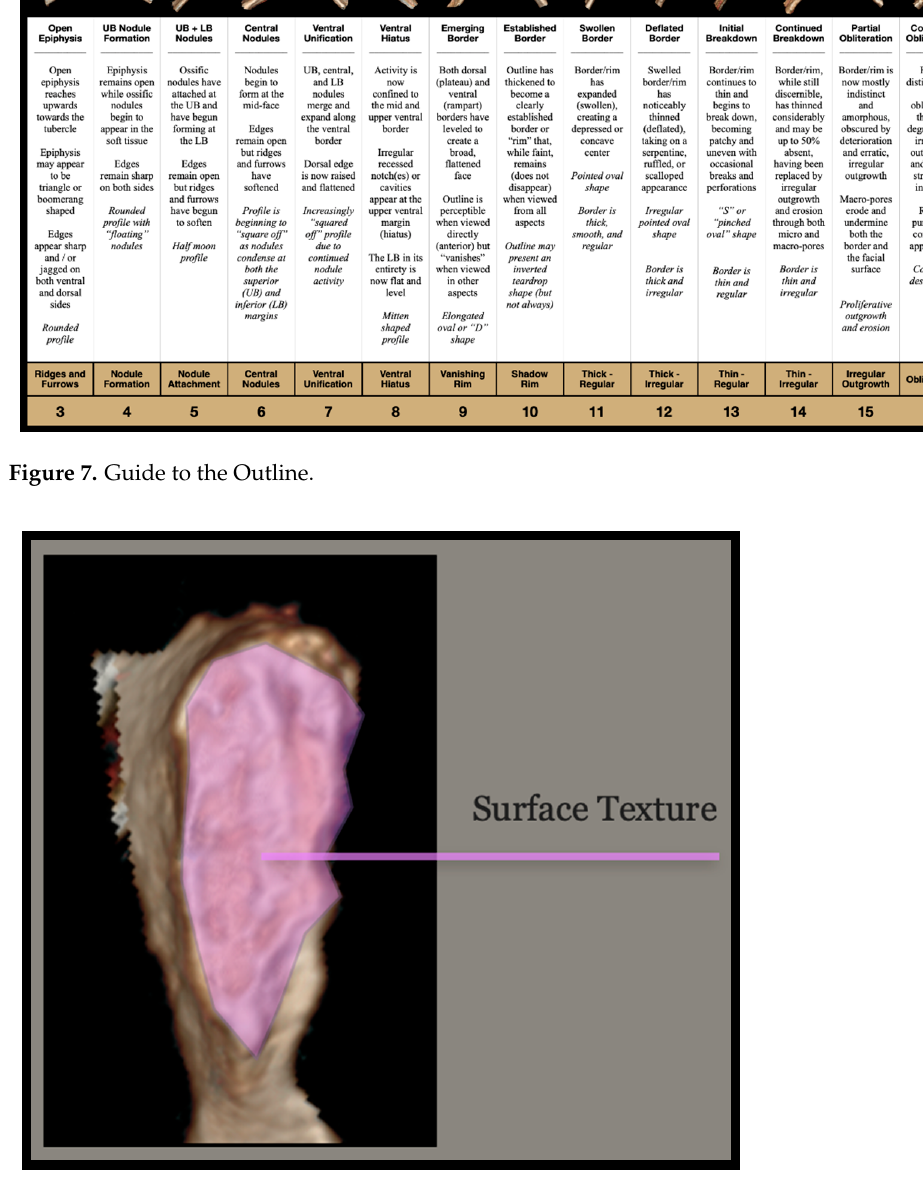
Figure 8. Surface Texture .